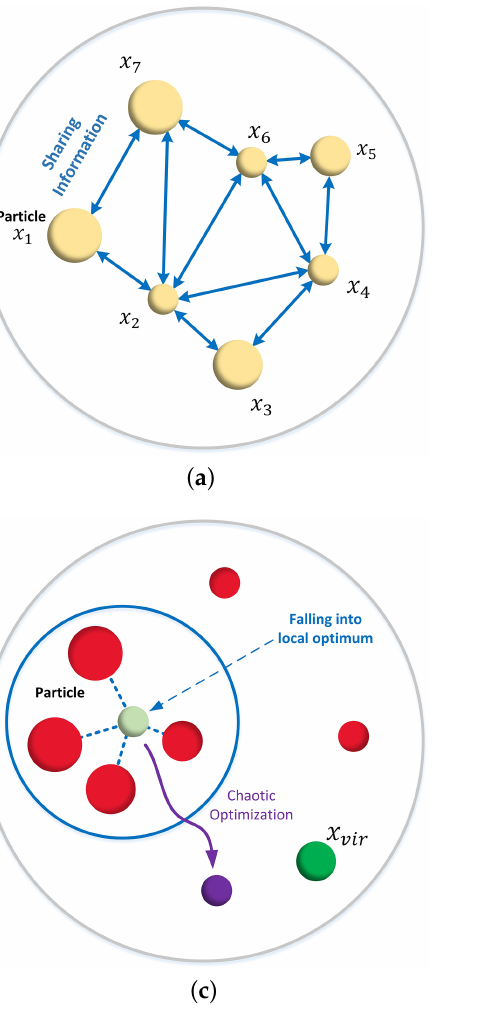
Figure 3. Particle update process of FCPSO. ( a ) Information sharing between particles. ( b ) Define the virtual particle to get the global optimisation goal. ( c ) Deal with particle premature convergence using chaotic optimisation. ( d ) Particles move toward global optimisation